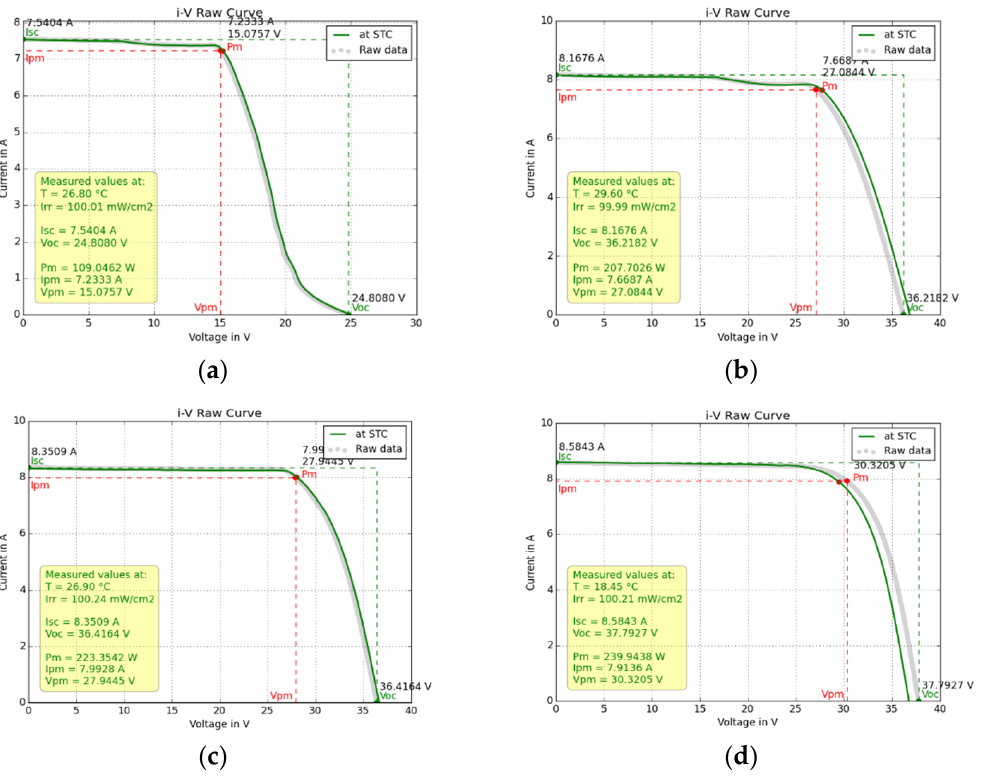
Figure 13. ( a ) The I–V of pc-Si ODT no1, extremely deformed due to organic-film deposition; ( b ) the I–V of the same module recovered from degradation; ( c ) the I–V of ODT module no2 of the same type as no1, ( d ) the I–V of the same type of module no3. Table 3. The electrical parameters, converted to STC, of 3 pc-Si ODT modules. The results for ODT module no1 are given twice, for the uncleaned module and with its glass cover cleaned.